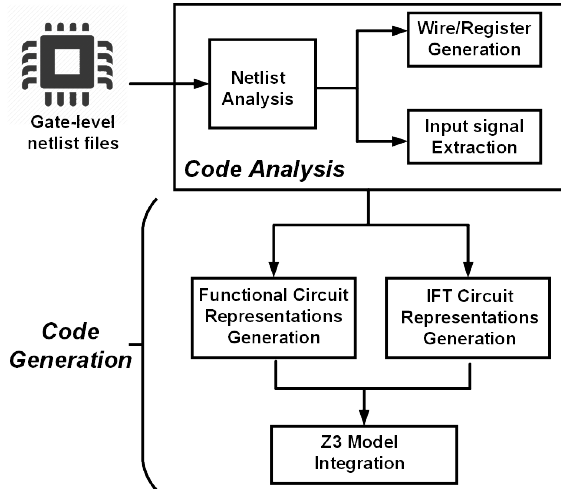
Figure 6. Block structure of the developed